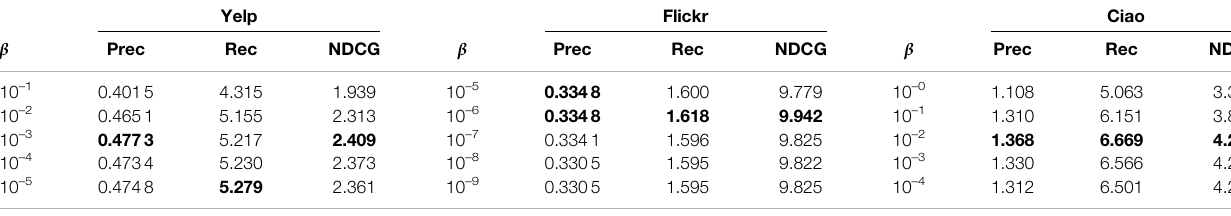
TABLE 10 | Performance of CGL with respect to different values of β ( K = 20). The best results are in bold. Yelp Flickr Ciao β Prec Rec NDCG